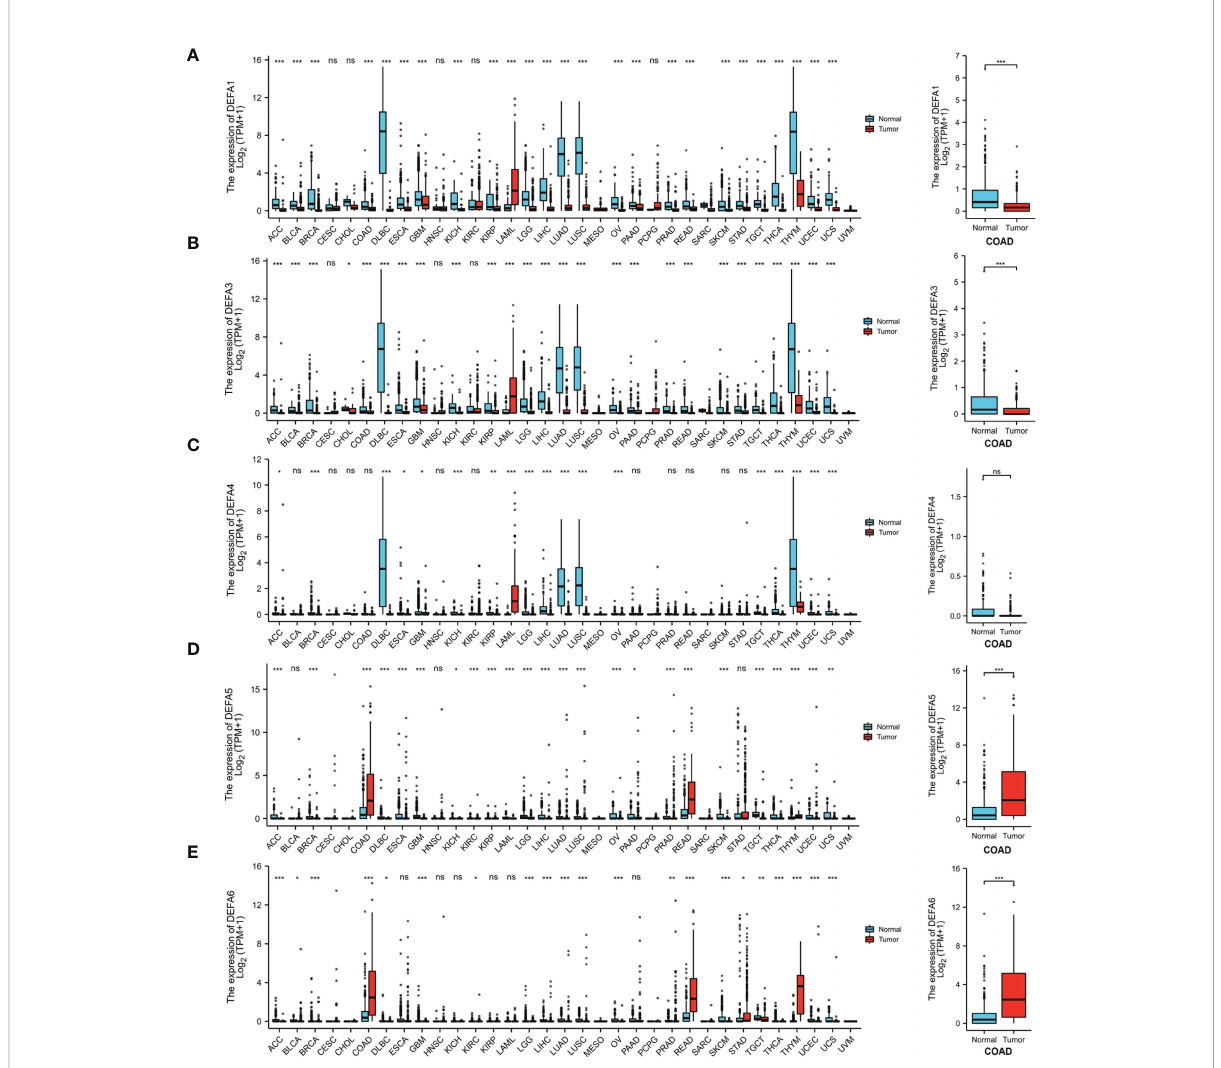
FIGURE 3 The transcription levels of DEFA factors in different types of cancers (UCSC XENA) (A) . The expression level of DEFA1 in in different types of cancers; (B) . The expression level of DEFA3 in in different types of cancers; (C) . The expression level of DEFA4 in in different types of cancers; (D) . The expression level of DEFA5 in in different types of cancers; (E) . The expression level of DEFA6 in in different types of